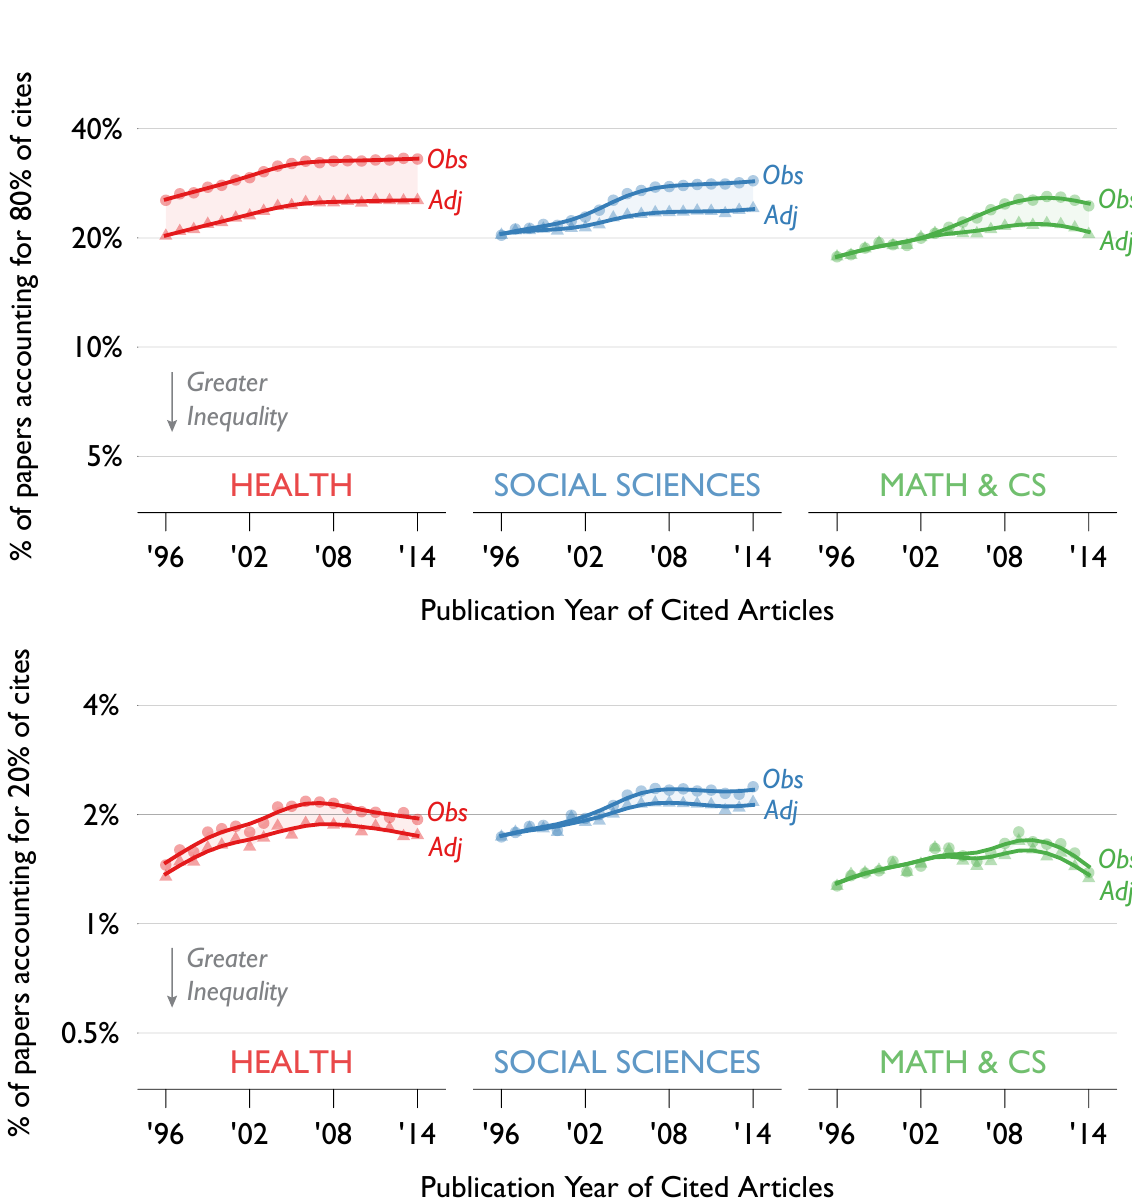
Figure 9: Percentage of articles accounting for 80 percent and 20 percent of all citations within two years